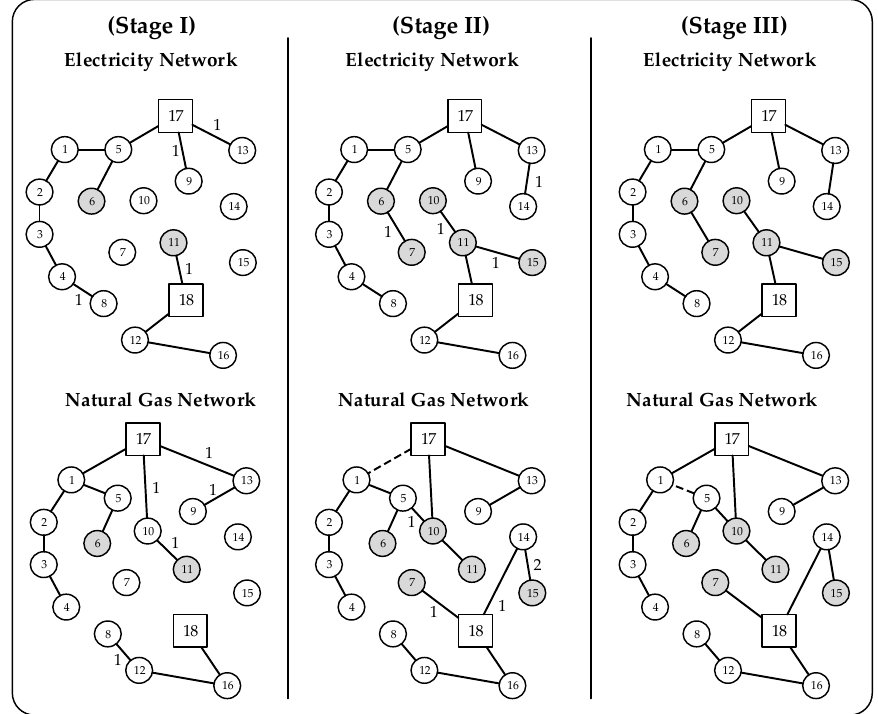
Figure 4. Optimal networks topologies at each stage.